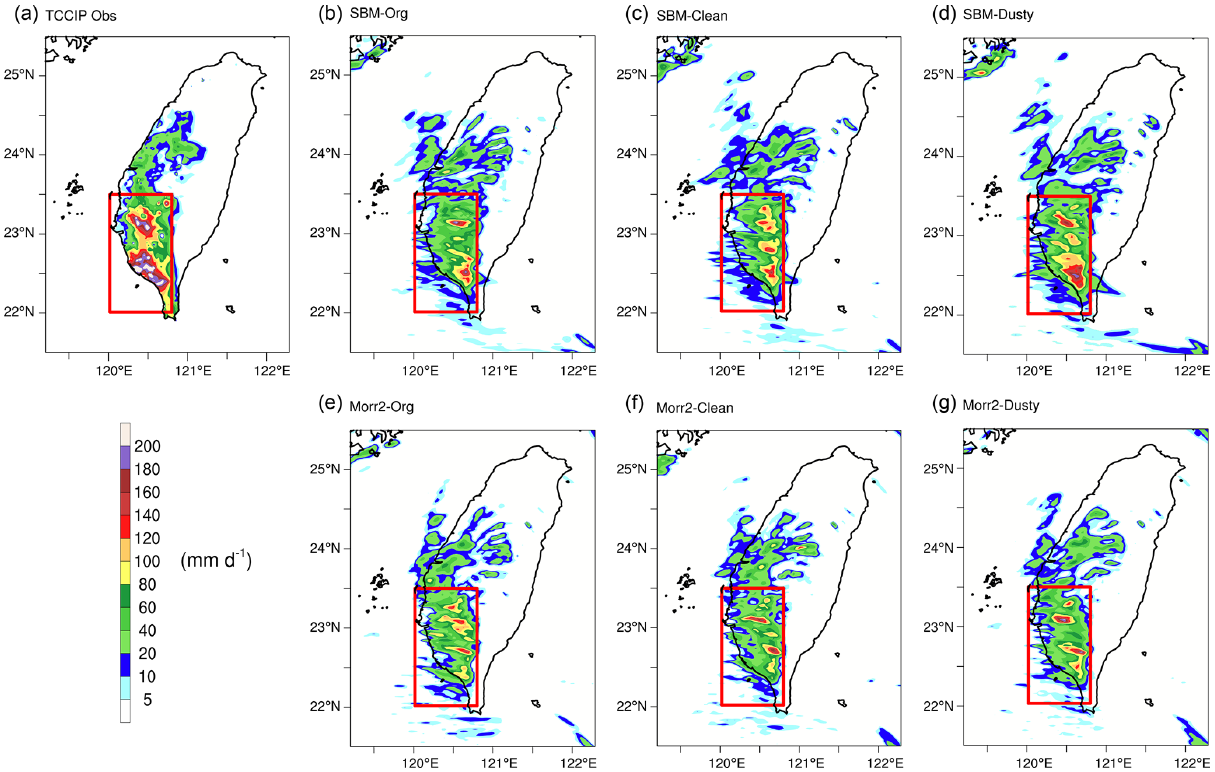
Figure 2. 24h accumulated precipitation ( r 24h ) (LT 8 July 2006) observations from (a) TCCIP, and simulations by (b) SBM-Org, (c) SBM- Clean, (d) SBM-Dusty, (e) Morr2-Org, (f) Morr2-Clean, and (g) Morr2-Dusty. The heavy precipitation is mainly located in the area marked by the red box